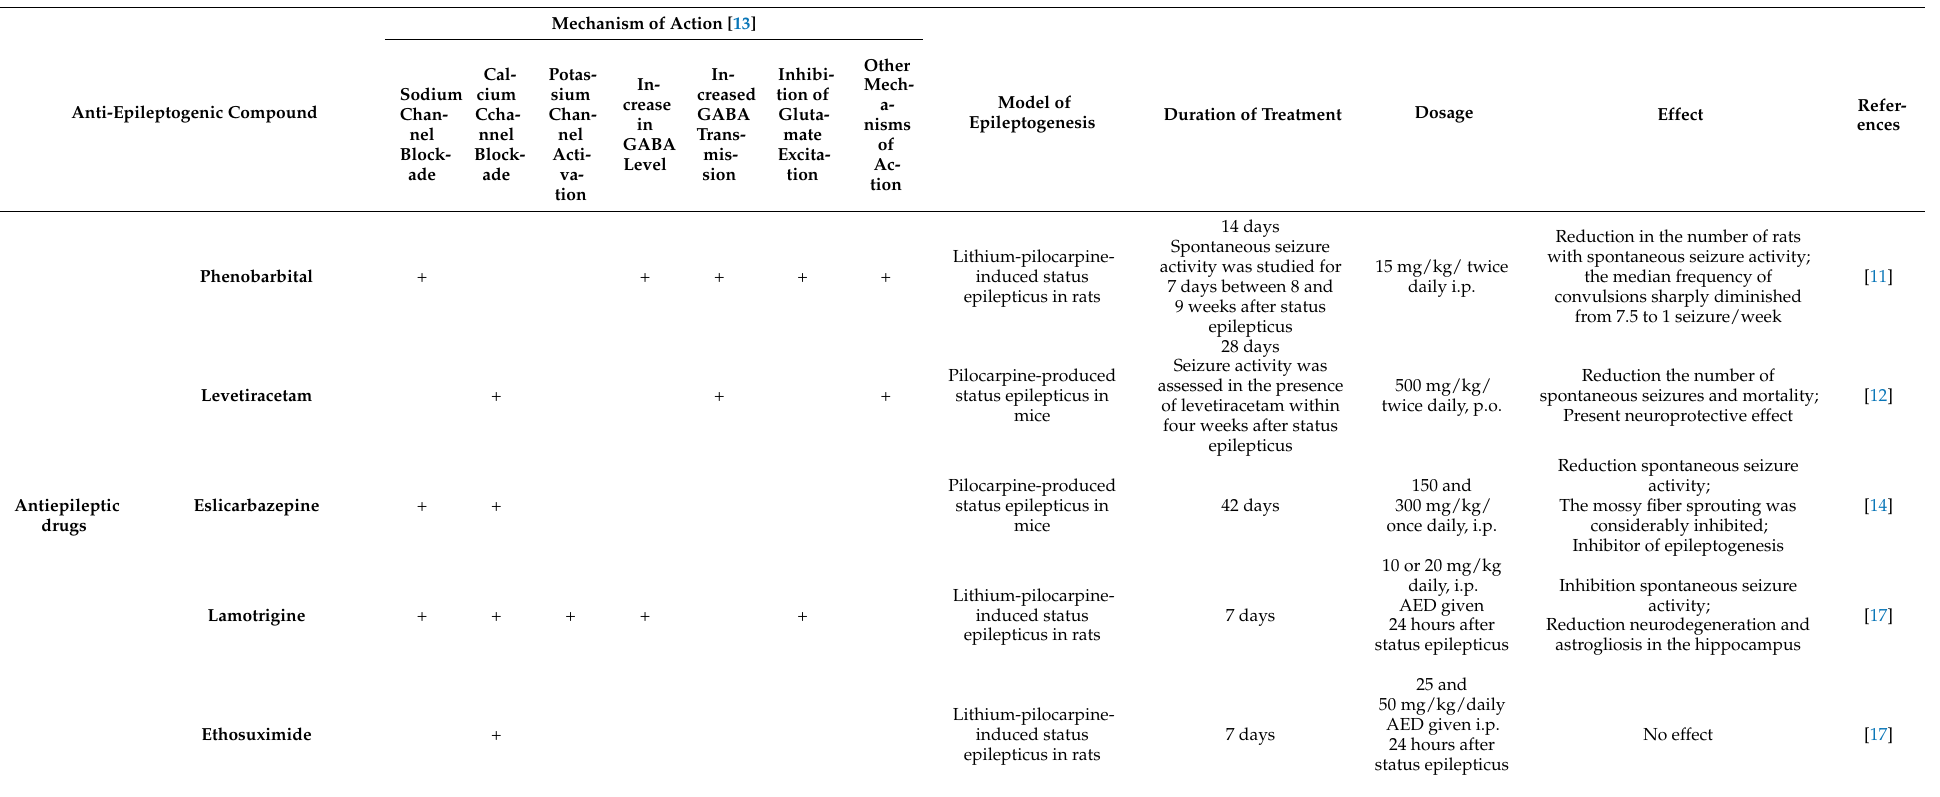
Table 1. Anti-epileptogenic potential of various drugs and